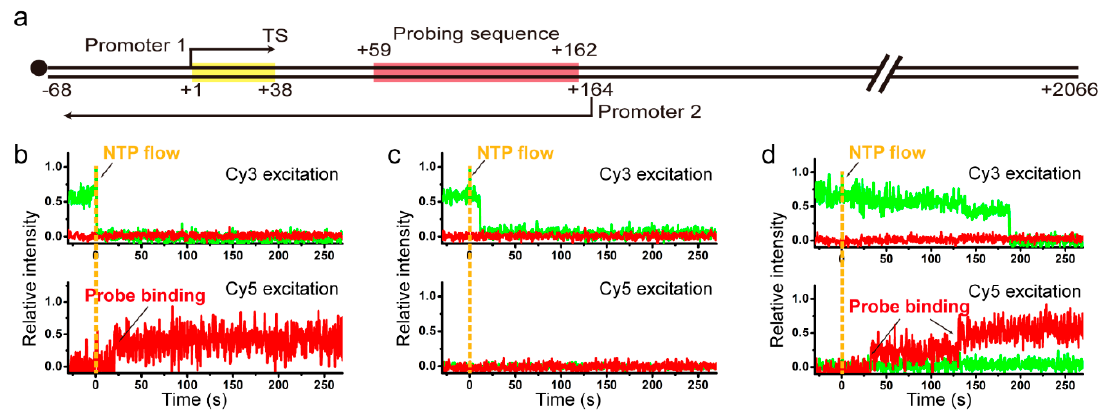
Figure 3 . ( a ) DNA template L+2P containing two oppositely oriented promoters and a probing sequence between them. When the probing sequence is transcribed from promoter 1 or 2, transcripts can be probed with Cy5-labeled sense or antisense probe, respectively. ( b – d ) Representative Figure 2. P with the sense probe at Cy3 (top) and Cy5 (bottom) excitations for reinitiation at promoter 1 ( b ), for no reinitiation occurring after TS-termination ( c ), and for TS-readthrough ( d ).